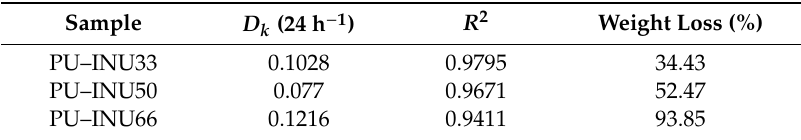
Figure 7. Degradability rate under specific pH and temperature conditions (7.4 at 37 °C) of the different PU–INU synthesized. Table 4. Results of degradation rate in physiological conditions (pH 7.4 and 37 ◦ C) and weight loss percentage after an elapsed time of two months of experiments.